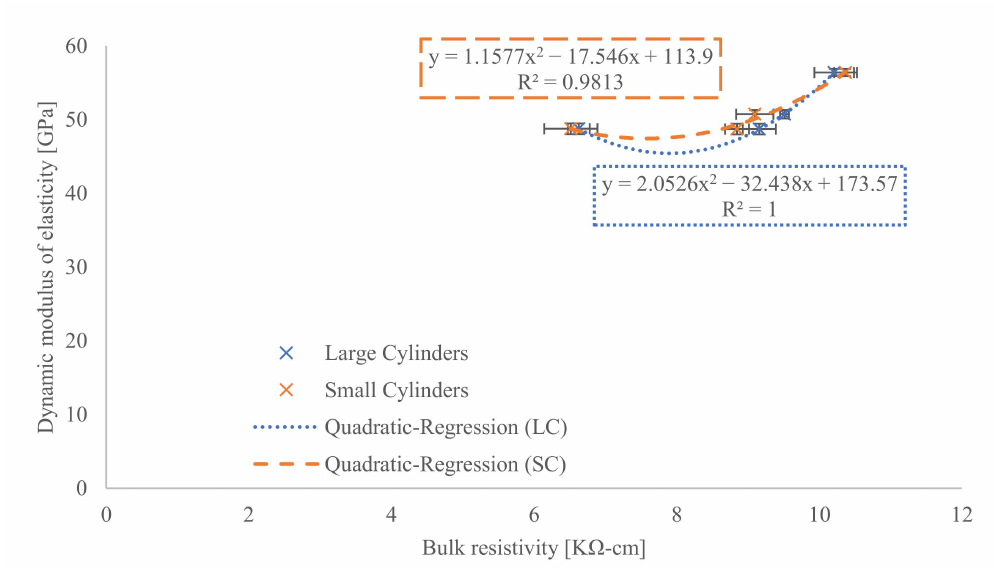
Figure 10. Quadratic regression analysis of the relationship between bulk electrical resistivity and dynamic modulus of elasticity (LC = Large Cylinders, SC = Small Cylinders).